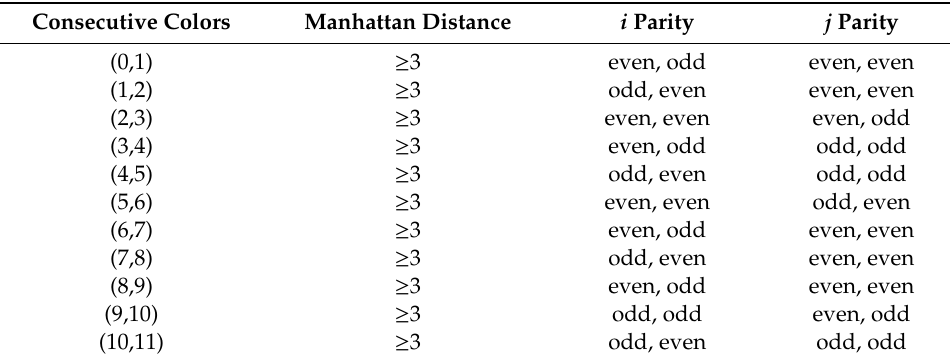
Table 2. Relationships between successive vertices for the L(3,1) coloring algorithm. Consecutive Colors